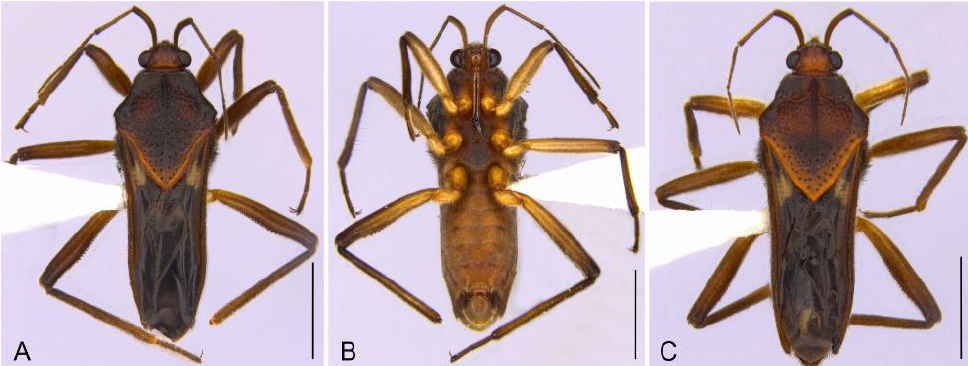
Figure 10. Paravelia nieseri from Piauí state, macropterous males, habitus. ( A , C ). Dorsal view. ( B ). Ventral view. Scale bars: 2 mm.